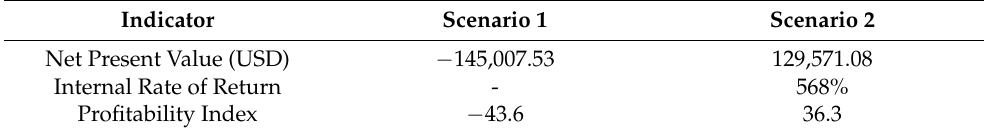
Table 7. Summary of financial